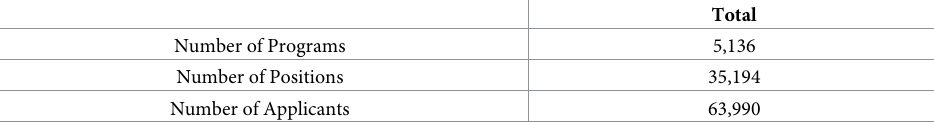
Table 1. National resident matching program number of programs, applicants, and positions in 2021.